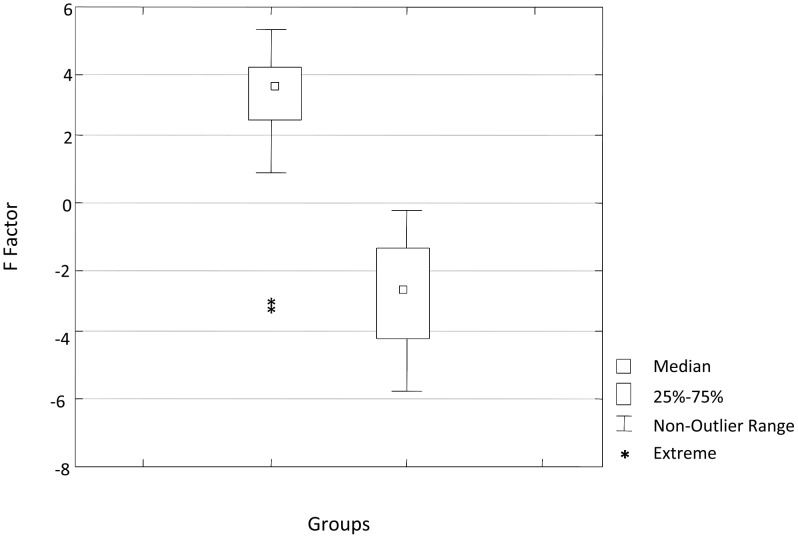
Distribution of variables used in the MCA according to their contribution to the F factor.(DIST_VAC = Distance to areas with recommended YF vaccination; DIST_UC = Distance to a biodiversity conservation unit; MATA = proportion of riparian forest; TRAF = Number of main routes of illegal wildlife traffic up to 100 km away; HUMID = Humidity (Pluviosity/RET); VENT = Influence of the direction of dominant wind routes; SFIHA = Surveillance for Febrile Ictero-hemorrhagic Syndrome (SFIHS).